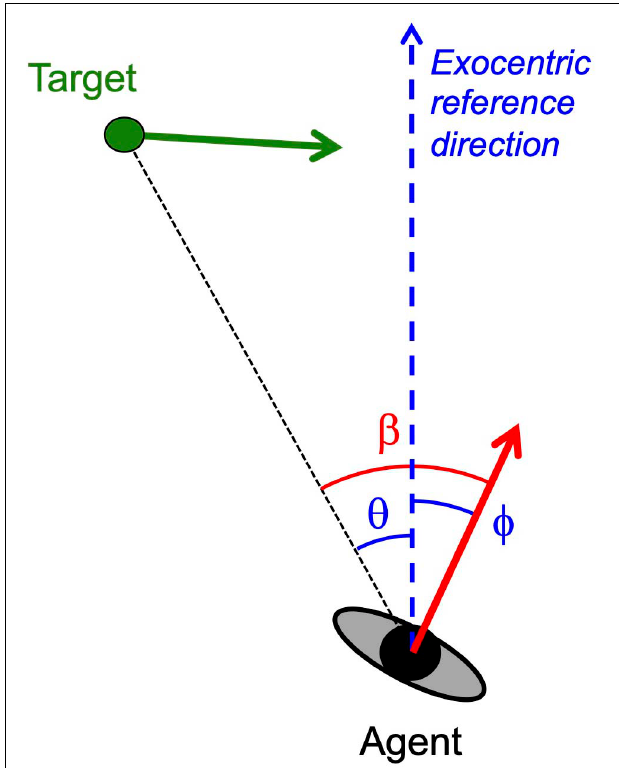
FIGURE 1 | Definition of variables in a plan view of an agent moving through an environment containing a target moving in the same plane. Instantaneous velocity vectors are represented by arrows (red for agent, green for target). Agent heading φ and target bearing θ are defined with respect to an exocentric reference direction (dashed blue line). Target-heading angle β is defined by the eccentricity of the target with respect to the agent’s direction of locomotion so that β = φ − θ . Uniform target movement is defined by invariance of the target’s velocity vector in both orientation and